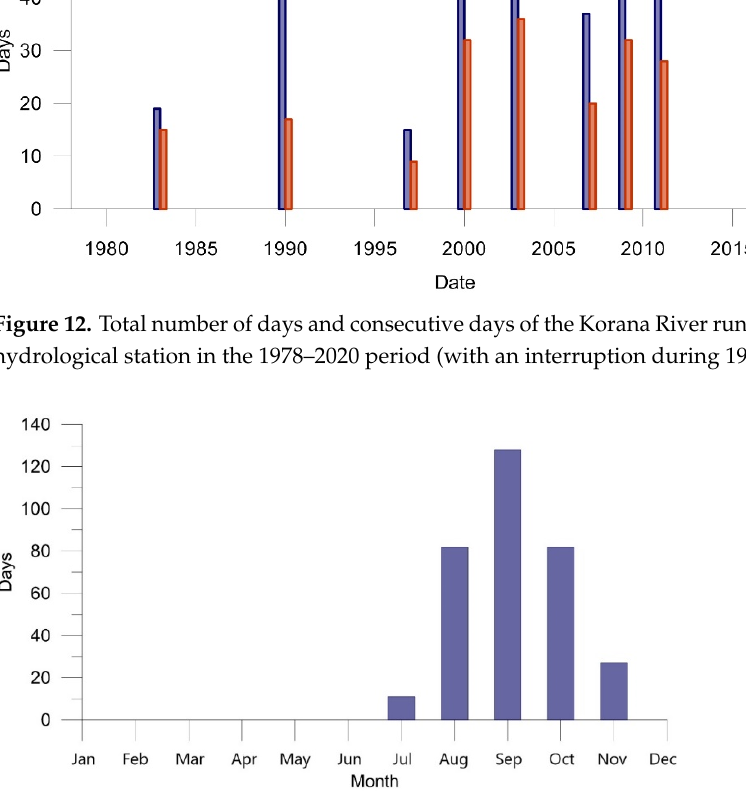
Figure 13. Total number of days per month with the Korana River running dry at the Luketi ć i hydrological station in the 1978–2020 period.